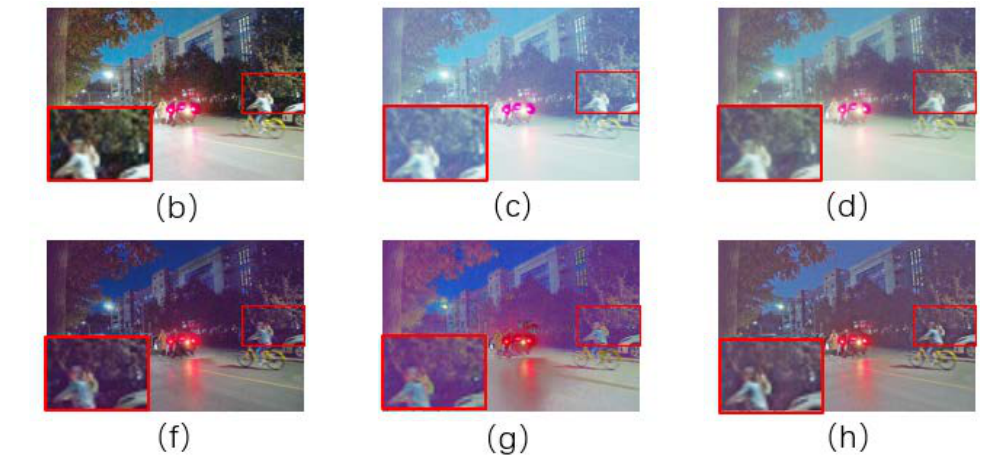
Figure 4. Contrast of outdoor image enhancement effect. ( a ) Original image; ( b ) HE; ( c ) Retinex; ( d ) MSR; ( e ) MSRCP; ( f ) LIME; ( g ) RetinexNet; ( h ) Ours.